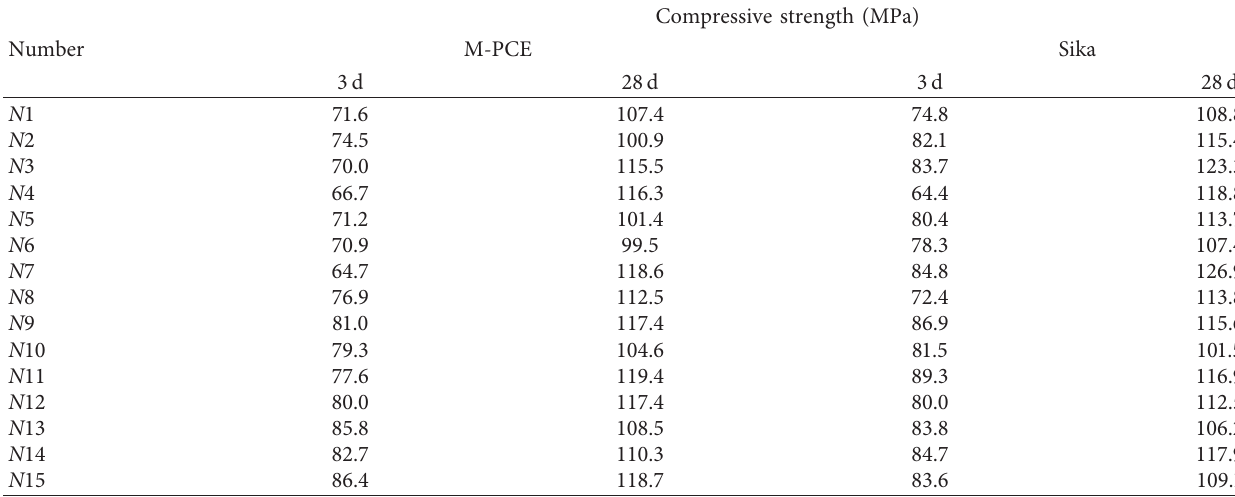
Table 5: Compressive strength of